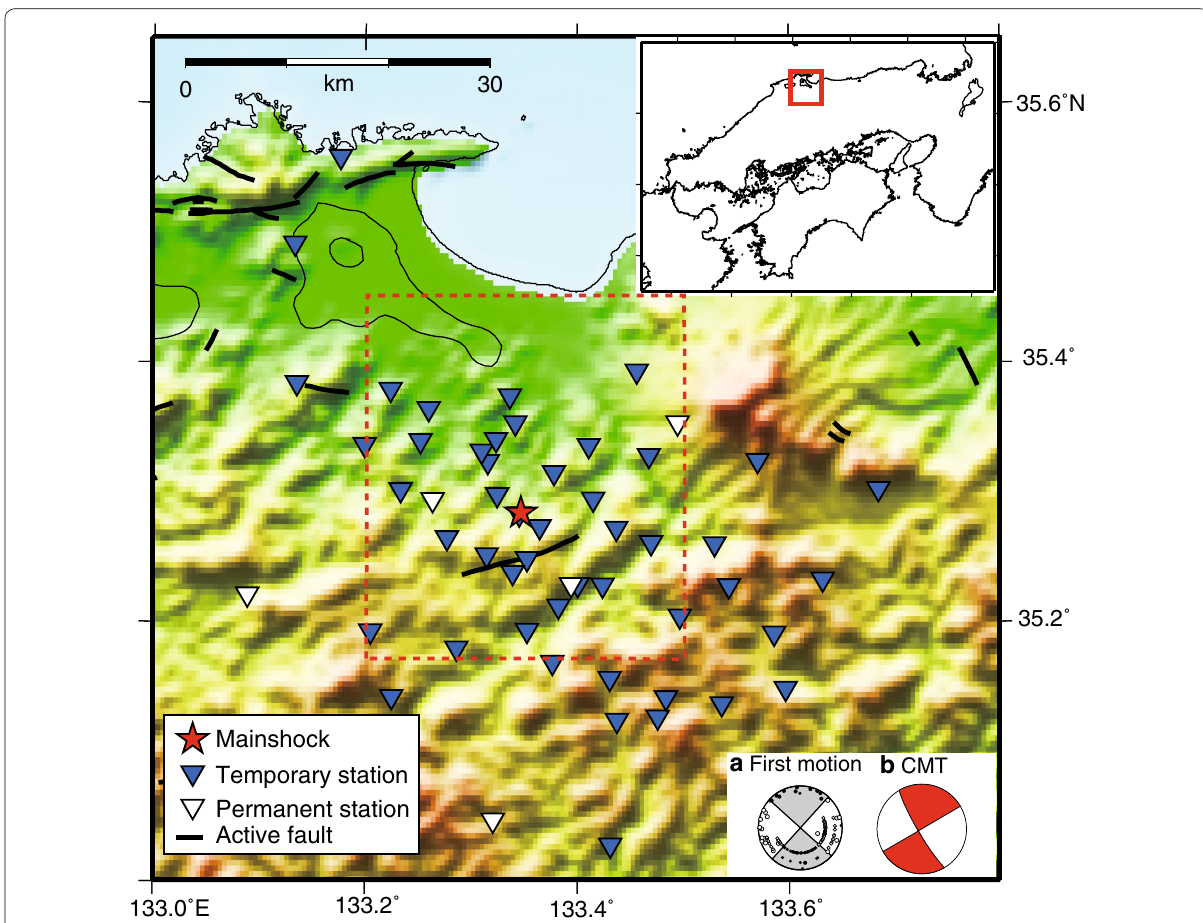
Fig. 1 Map showing the spatial distribution of seismic stations ( blue : temporary stations, white : permanent stations). The red star indicates the start- ing point of rupture during the 2000 Western Tottori Earthquake. The area indicated by the broken red rectangle corresponds to the area appearing in Figs. 2, 3, and 4. In the inset map , the target region is shown with respect to the western part of the Japanese Islands. The thick black lines indicate the surface traces of active faults compiled by the Research Group for Active Faults in Japan (1991). The focal mechanism of the mainshock deter- mined using the P-wave polarities (Ohmi et al. 2002) and CMT inversion (Fukuyama et al. 2003) are shown in ( a ) and ( b ),